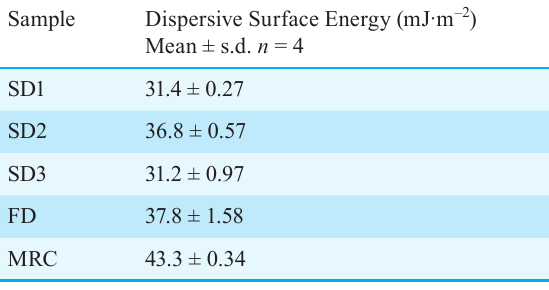
Table 5 Surface energy of food powder samples at surface